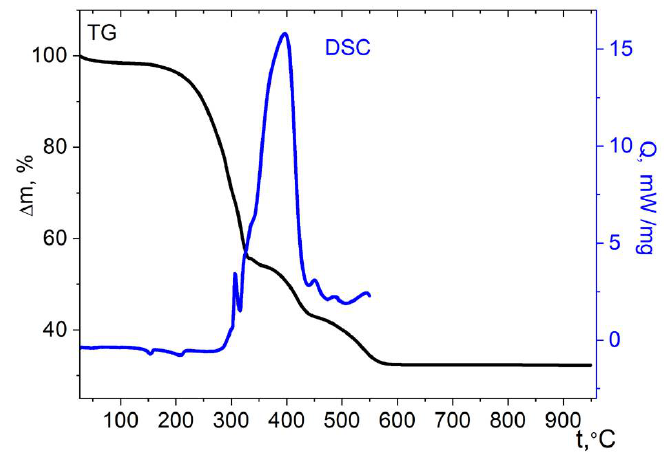
Figure 12. Thermolysis of complex 4 under air. Thermolysis of compound 5 begins with the removal of the lattice toluene molecules, which corresponds to a loss of ≈16.8% of the mass in the range of 25–130 °C (the calculated content of toluene is 17.4%). Further, up to a temperature of about 200 °C, a region of relative stability of the desolvated complex is noted (Figure 13). Weight loss at a higher temperature, before the oxidation starts, can be explained by the partial removal of the volatile bipyridyl ligand. At ≈260 °C, an active exothermic oxidation of the organic part of the complex begins, leading, according to powder X-ray data, to the tetragonal spinel CoMn 2 O 4 (Figure S7). The mass of the solid residue (21.4 ± 2%) corresponds well to the calculated one (22.2%).